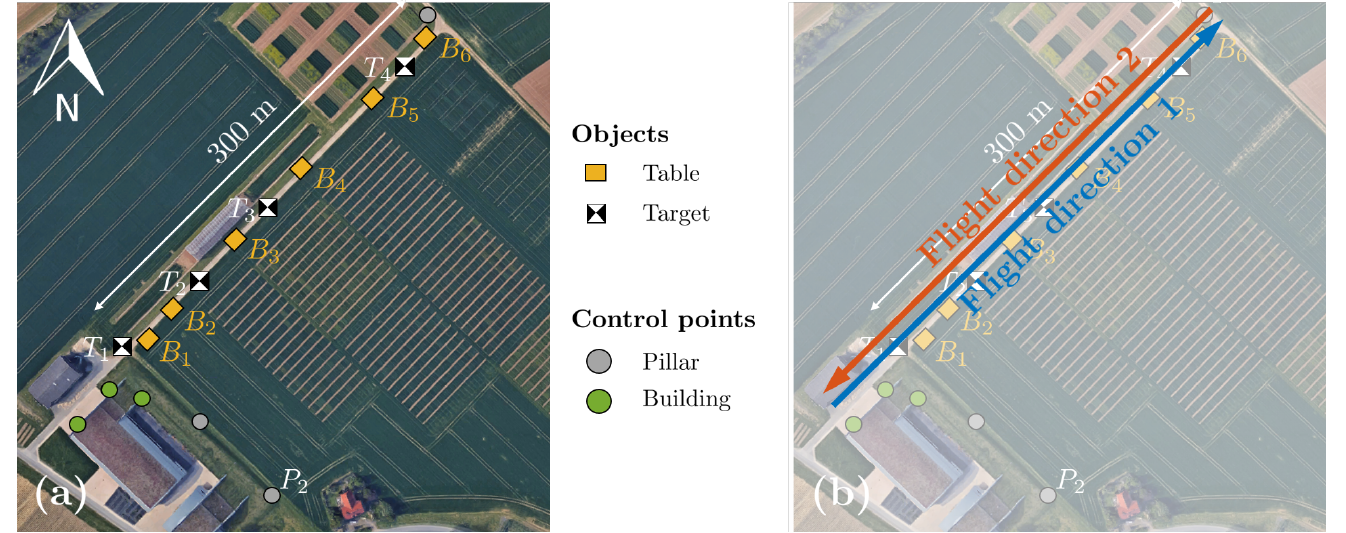
Figure 3. Study area for the analysis of single strip measurement with included objects ( a ) and the two flight directions of the individual measurements ( b ), © https://www.google.de/maps/ (accessed on 14 May